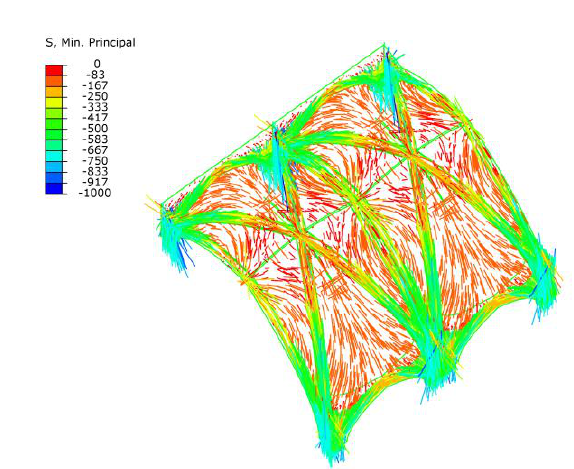
Figure 10. St. Bassiano Church: Vector plot of the compressive principal stresses due to self-weight (without settlement)